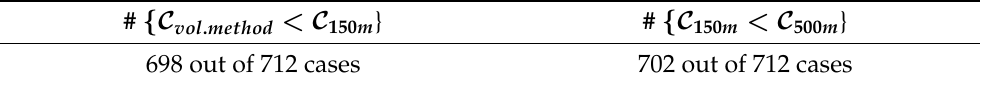
Table 3. Number of cases where airspace volumization vol has minimum cost (left) and number of cases where the flight corridor at 150 m has lower cost than the corridor at 500 m.